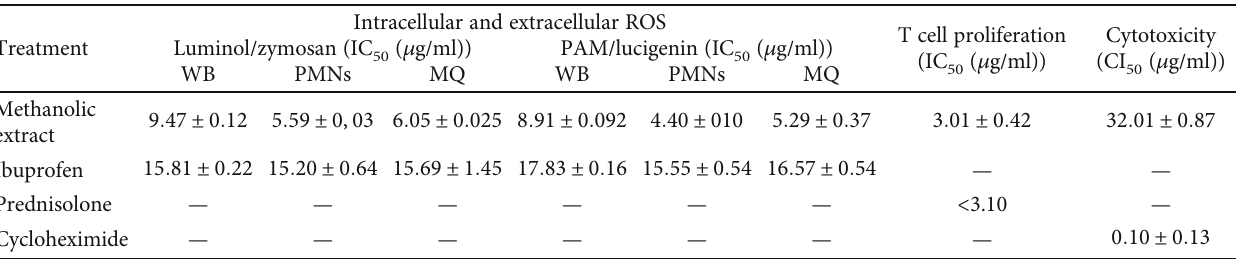
Table 2: IC value of methanolic extract of D. benthamianus stem bark on ROS production evaluated by zymosan/PMA-ampli fi ed 50 chemiluminescence, on T-cell proliferation and Cytotoxicity.